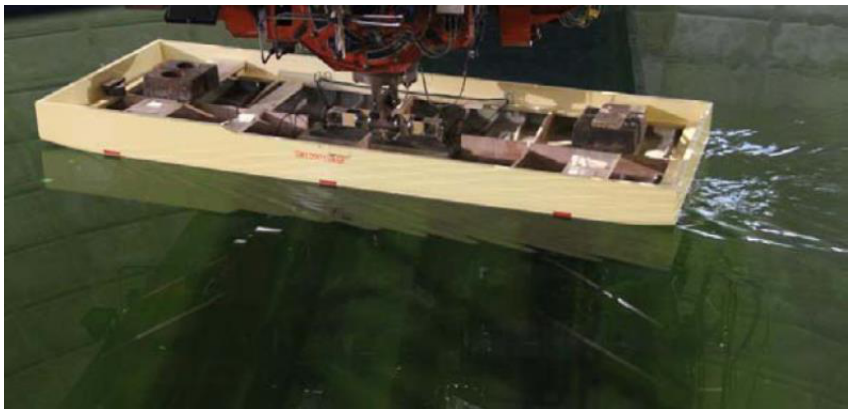
Figure 4. Photo of a 1/25 captive model test.